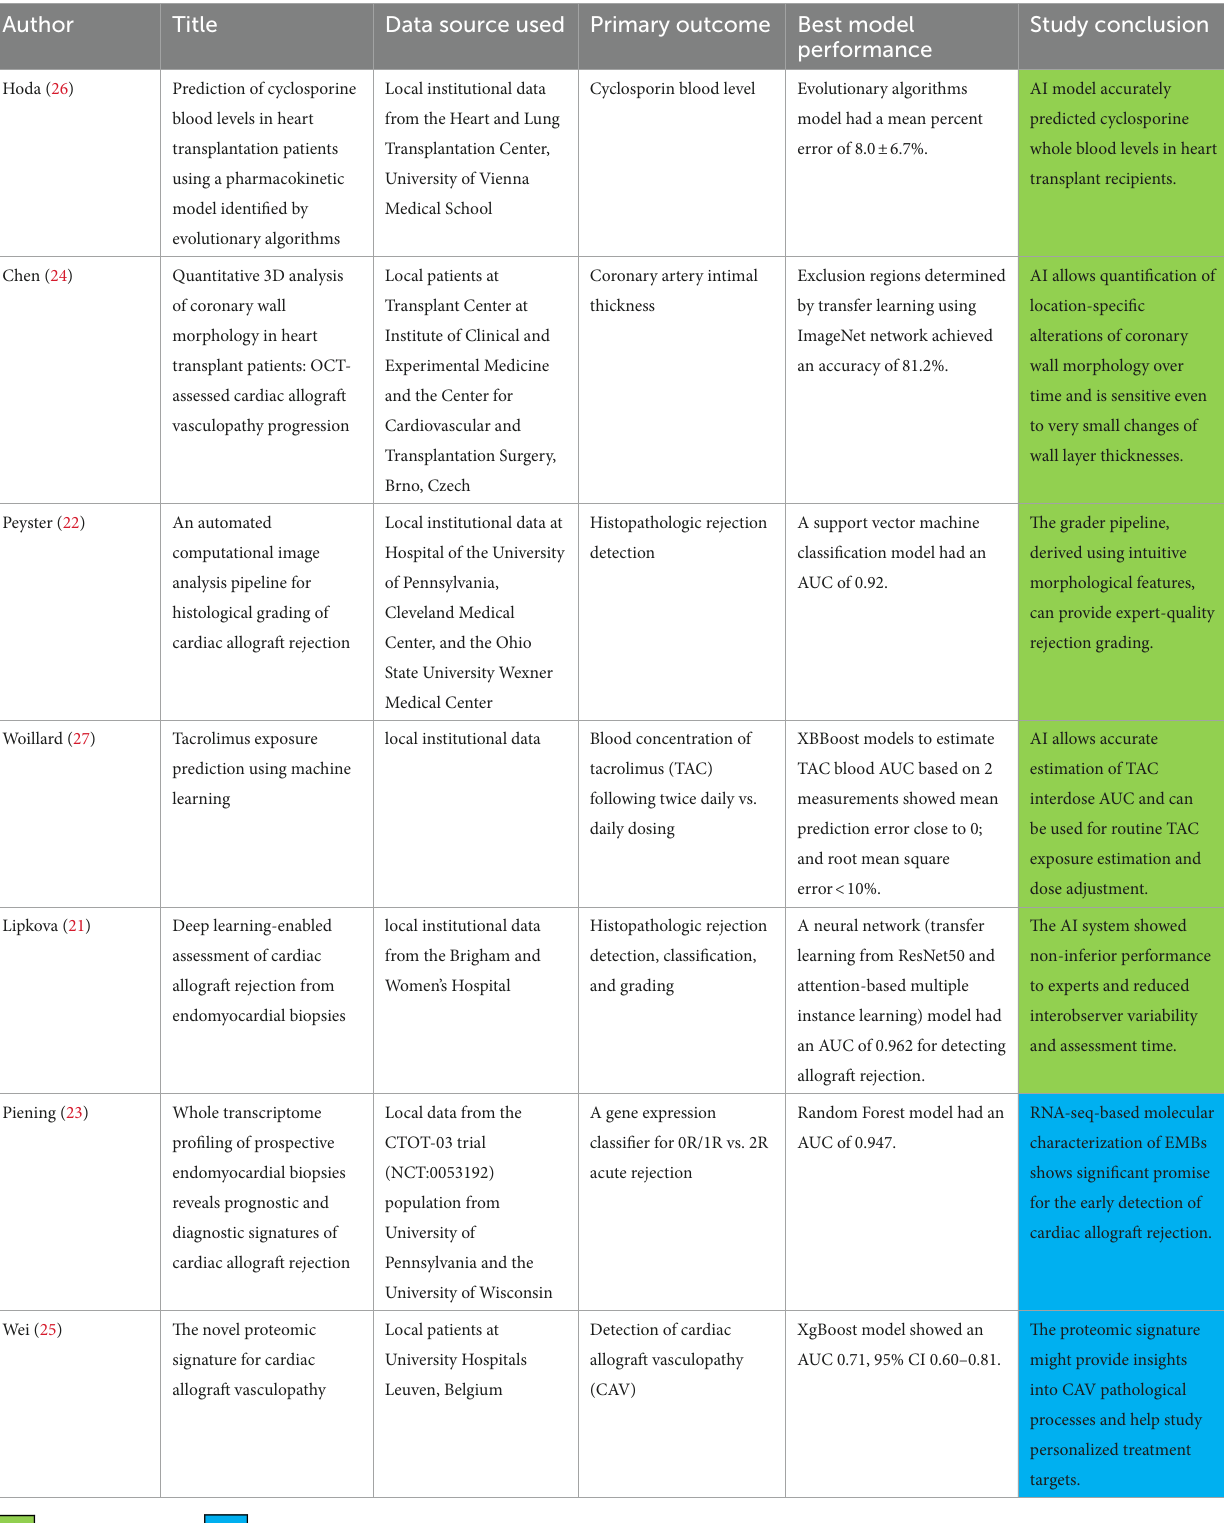
TABLE 2 Summary of publications describing artificial intelligence application in practicing post heart transplant